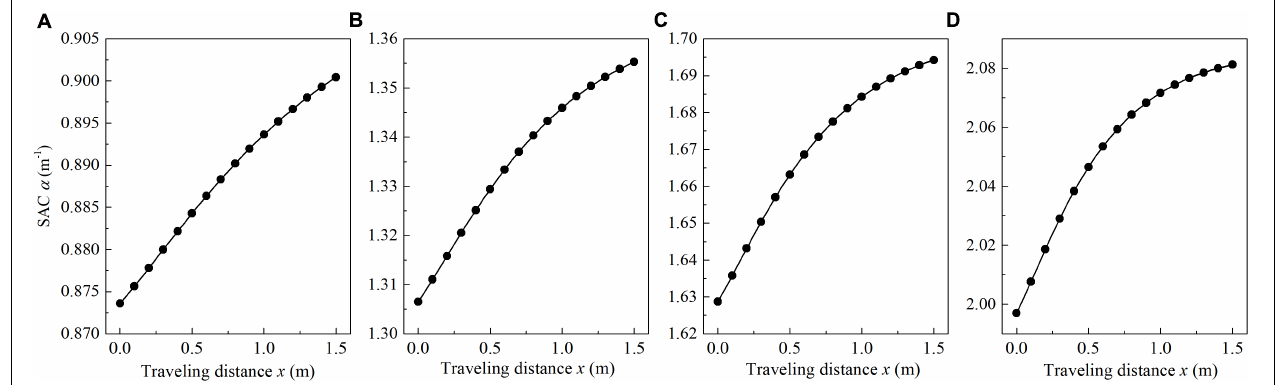
FIGURE 5 | Spatial attenuation coefficient versus traveling distance at different γ . (A) γ = 2.0; (B) γ = 2.8; (C) γ = 3.6; (D) γ = 4.8. ( σ s = 5.09 MPa).